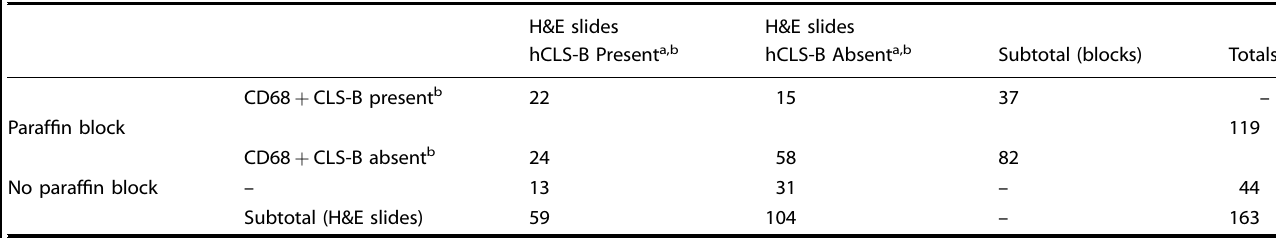
Table 1. Presence of CLS-B detected by H&E sections (hCLS-B) versus CD68 immunohistochemistry on paraf fi n